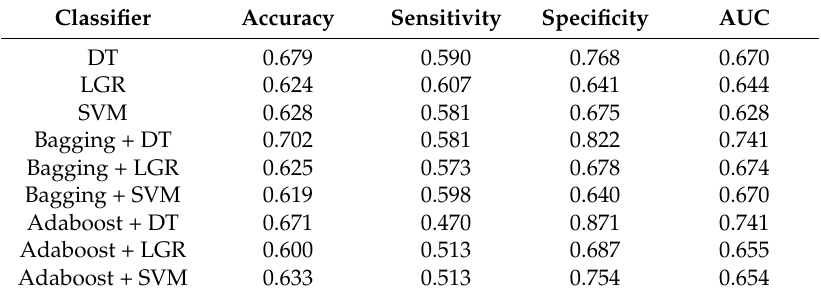
Table 4. Results of classification performance. DT: decision tree; LGR: logistic regression; SVM: support vector machine; AUC: area under the receiver operating characteristic curve.